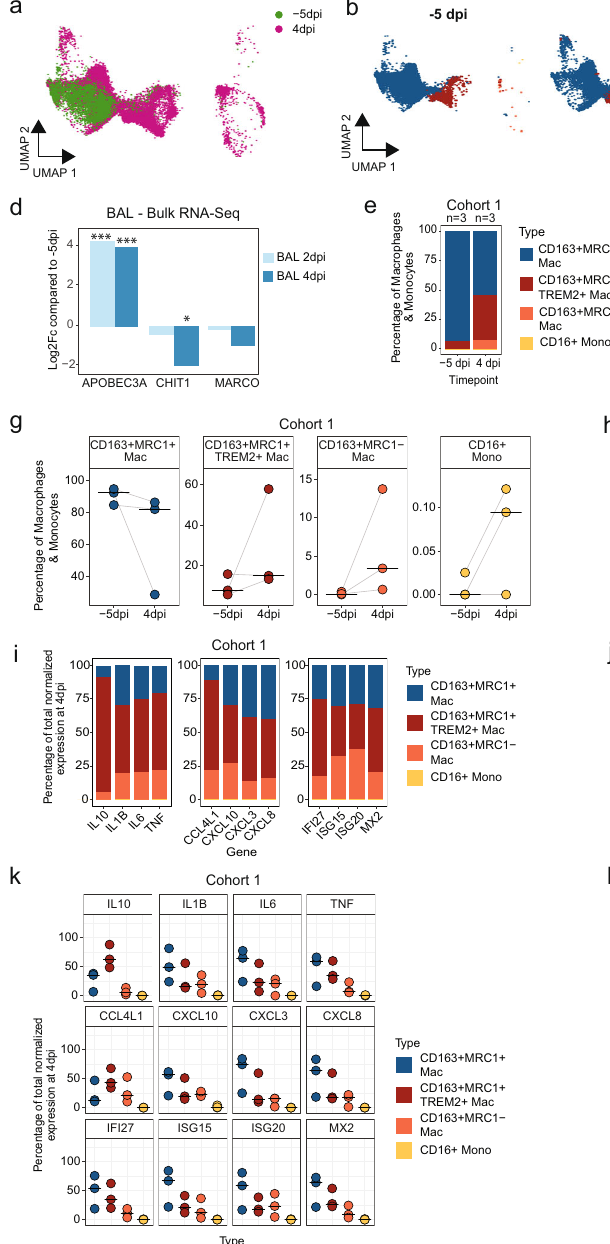
animal at − 5dpi and 4dpi from Cohort 1 ( n =3) ( g ) and at − 7dpi ( n =5) and 4 dpi ( n =6) for Cohort 2 ( h ). The black lines indicate the median. p values for Cohort 2 ( f ) for4 dpi vs. − 7 dpi:CD163+MRC1+=0.009,CD163+MRC1+TREM2+=0.03, and CD163+MRC1 − =0.004. Contribution of each macrophage/monocyte subset toward the production of the pro-in fl ammatory genes and ISG — Cohort 1 pooled ( i ),Cohort2pooled( j ),Cohort1individual( k )andCohort2individual( l ). p values for( l ):*=0.03.Thepercentagecontributionwascalculatedbydividingthesumof normalized expression of a given gene in a macrophage/monocyte subset by the sum of the normalized expression of the gene in all macrophage/monocyte sub- sets. a – c , e , g , i , k Cohort 1: n =3 for both − 5dpi and 4dpi, d Cohort 1: n =8 for 2dpi and n =4 for 4dpi, f , h , j , l Cohort 2: n =5 for − 7dpi and n =6 for 4 dpi. The blacklinesindicatethemedian.Statisticalanalysiswasperformedusingtwo-tailed Wilcoxon singed rank test for( g , k , l ) and two-tailed Mann – Whitney U test for( h ) in R v4.2.2. * p value <0.05, ** p value <0.01. Source data ( d – l ) are provided as a Source Data fi